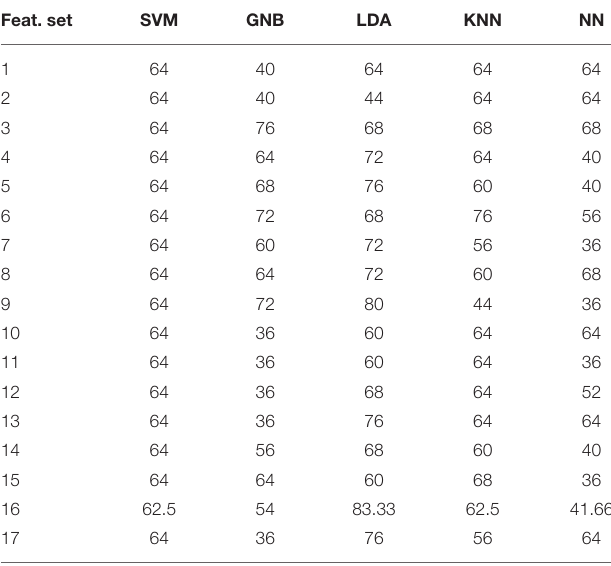
TABLE 8 | Performance of different models at different extracted features for unvoiced (U) modality obtained from AC channel. Feat. set